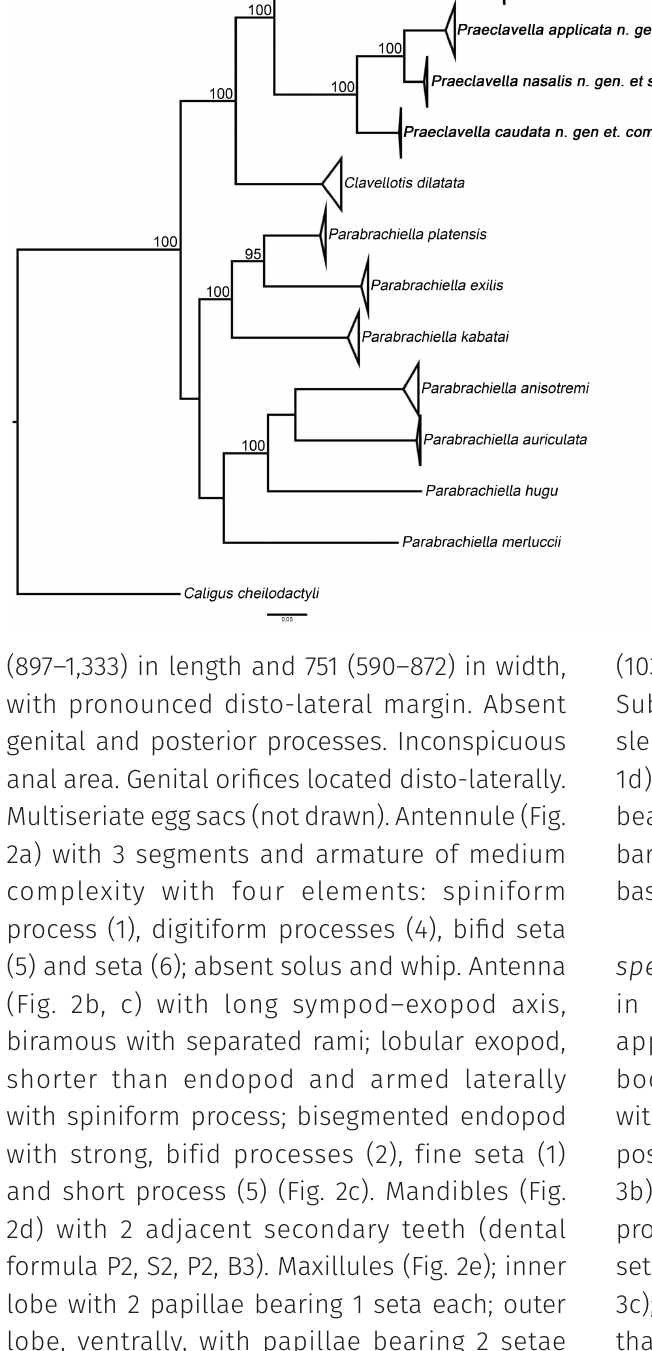
Figure 4. Phylogenetic tree of all the available Clavella - branch of the Lernaeopodidae family sequences constructed with Bayesian inference analysis of mtDNA COI